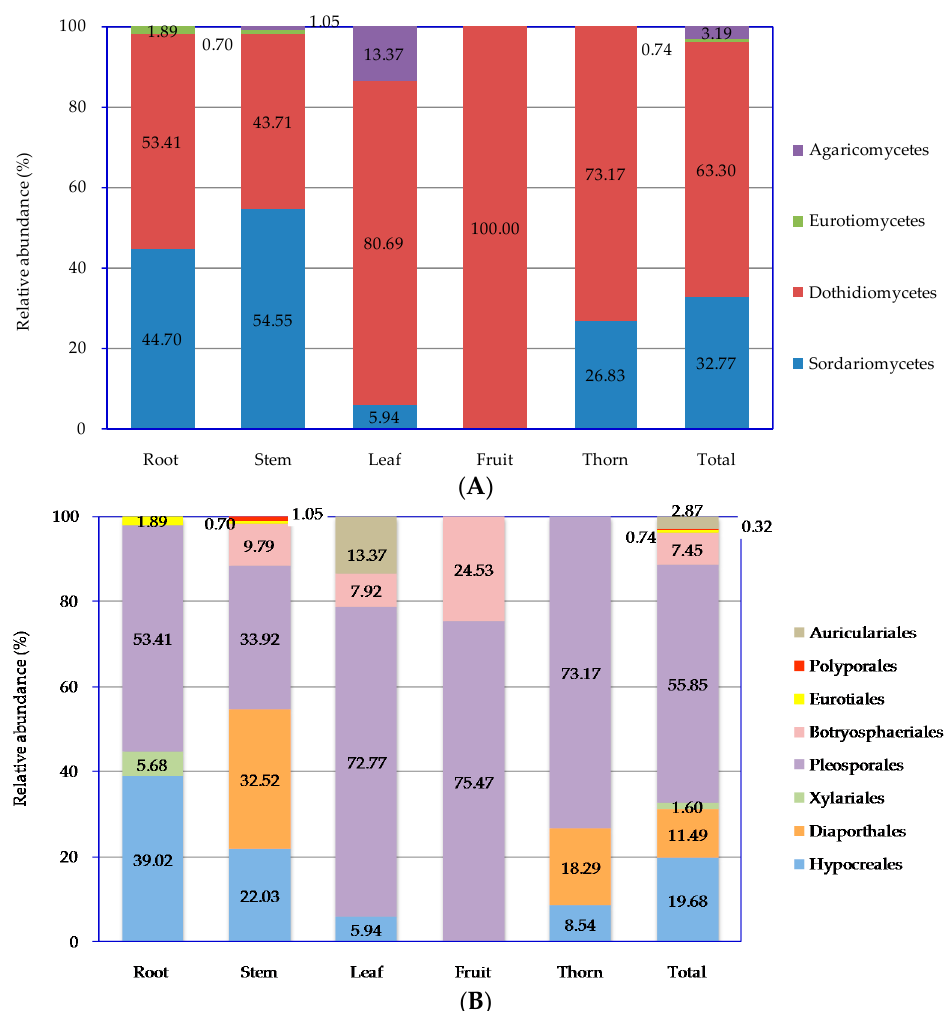
Figure 2. Relative abundance (%) of endophytic fungal at the level of class ( A ); and order ( B ) in different tissues and total plant of Z. bungeanum .